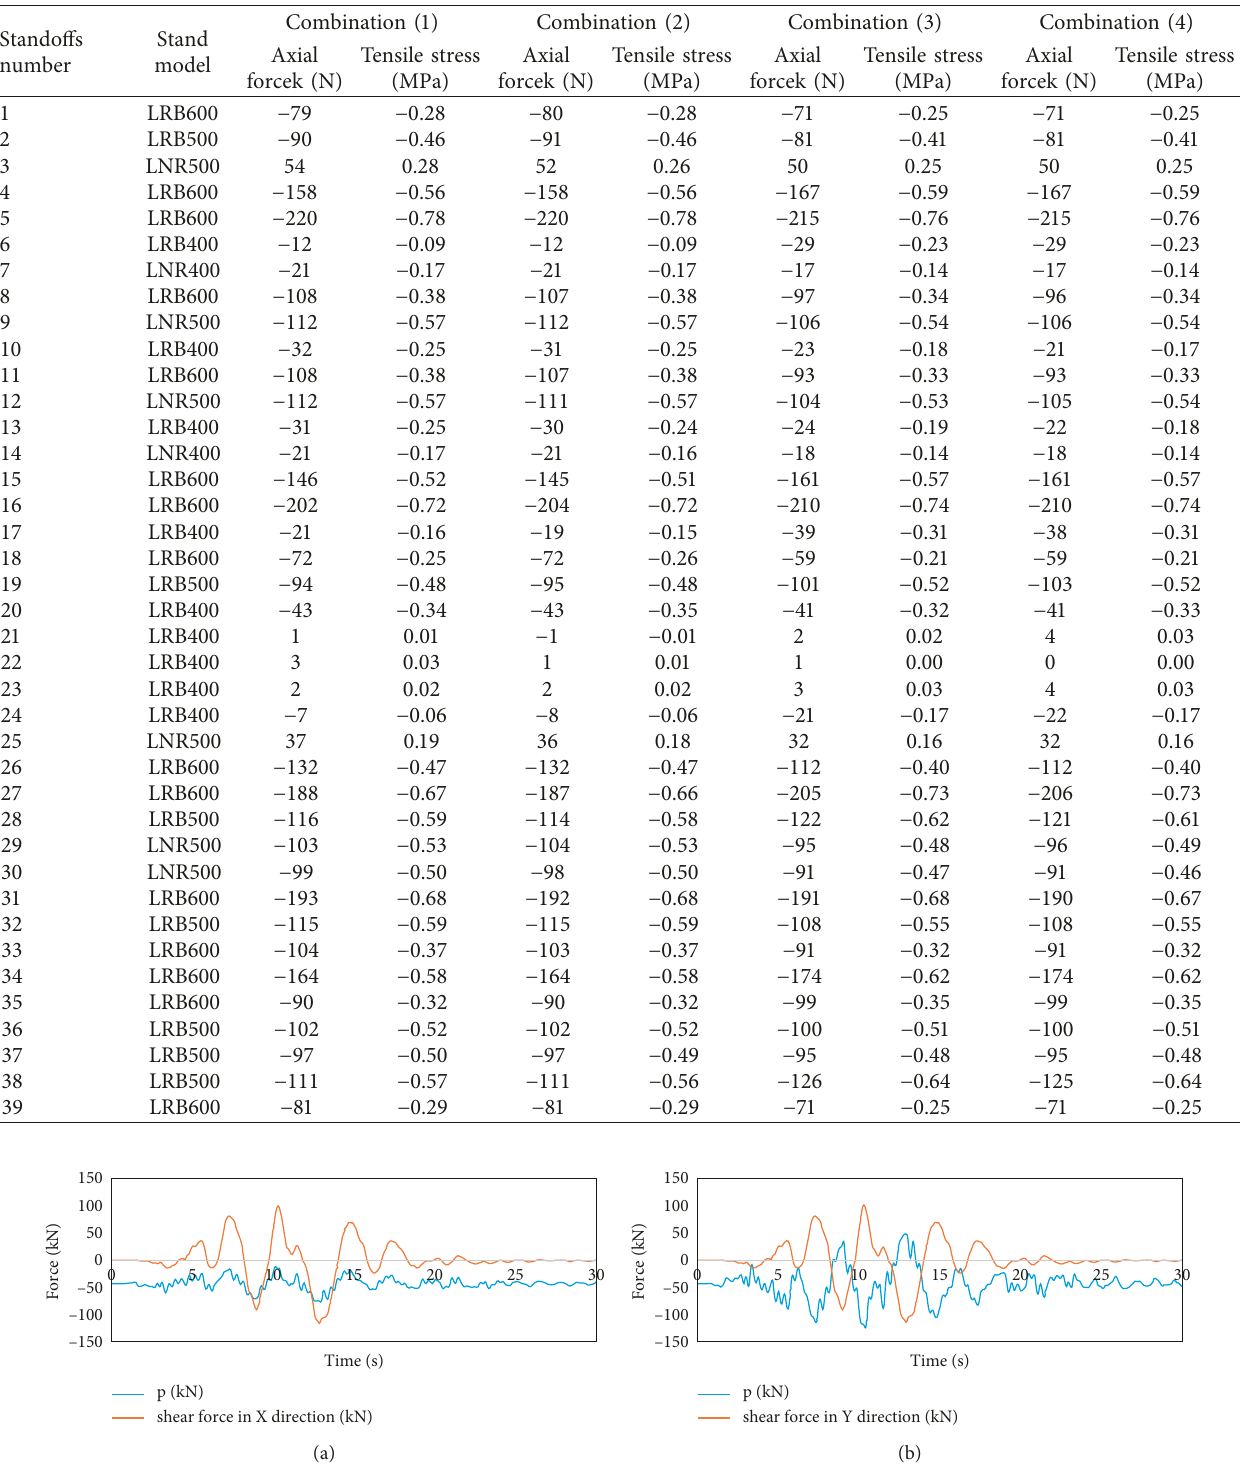
Table 7: Maximum tensile stress and minimum axial force under different load combinations.